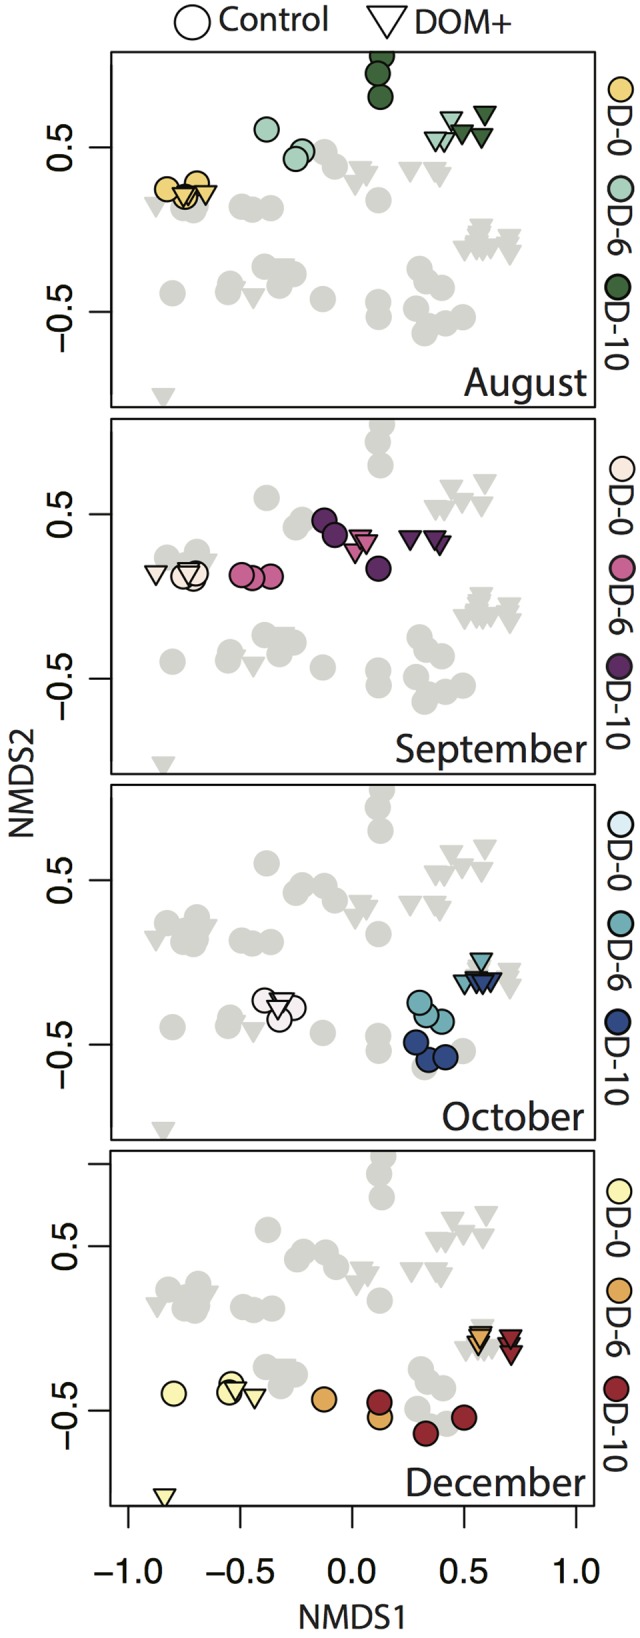
Non-metric multidimensional scaling (NMDS) of Bray–Curtis similarity indices based on OTU relative abundance across all four experiments. Each point corresponds to an individual mesocosm replicate (n = 3 per time point per treatment). All samples from all experiments are shown in each panel. Within each panel, a different experiment is highlighted with different colors corresponding to different sample days (0, 6, and 10), with the other experiments shown in gray. Control mesocosm communities are denoted by circles and DOM+ mesocosm communities are denoted by triangles.